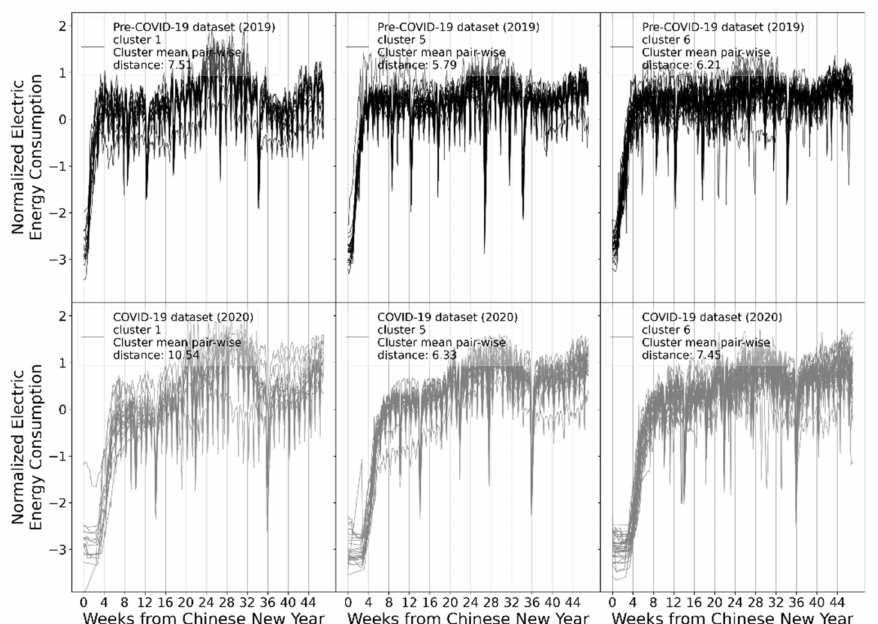
Figure 9. Comparison of the clustered pre-COVID-19 dataset and clustered COVID-19 dataset by using the cluster labels of the pre-COVID-19 clustering (selected clusters are shown; the top row is the clustered dataset of the pre-COVID-19 period, and the bottom row is the clustered dataset of the COVID-19 period; the start date of all the subplots is the Chinese New Year of the respective